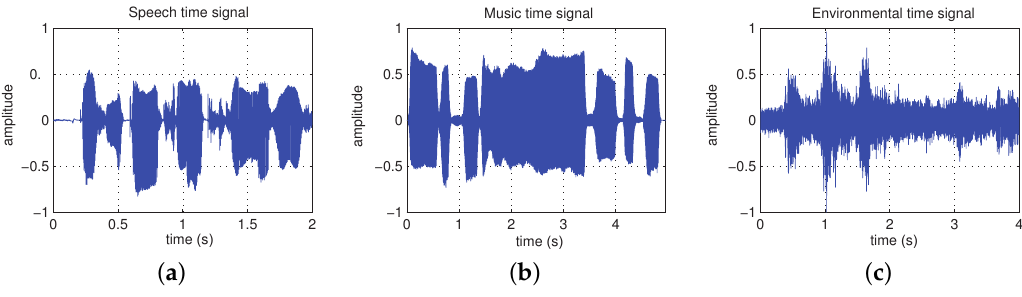
Figure 3. Time envelope of a: ( a ) speech signal; ( b ) music signal (trumpet); ( c ) environmental sound signal (traffic